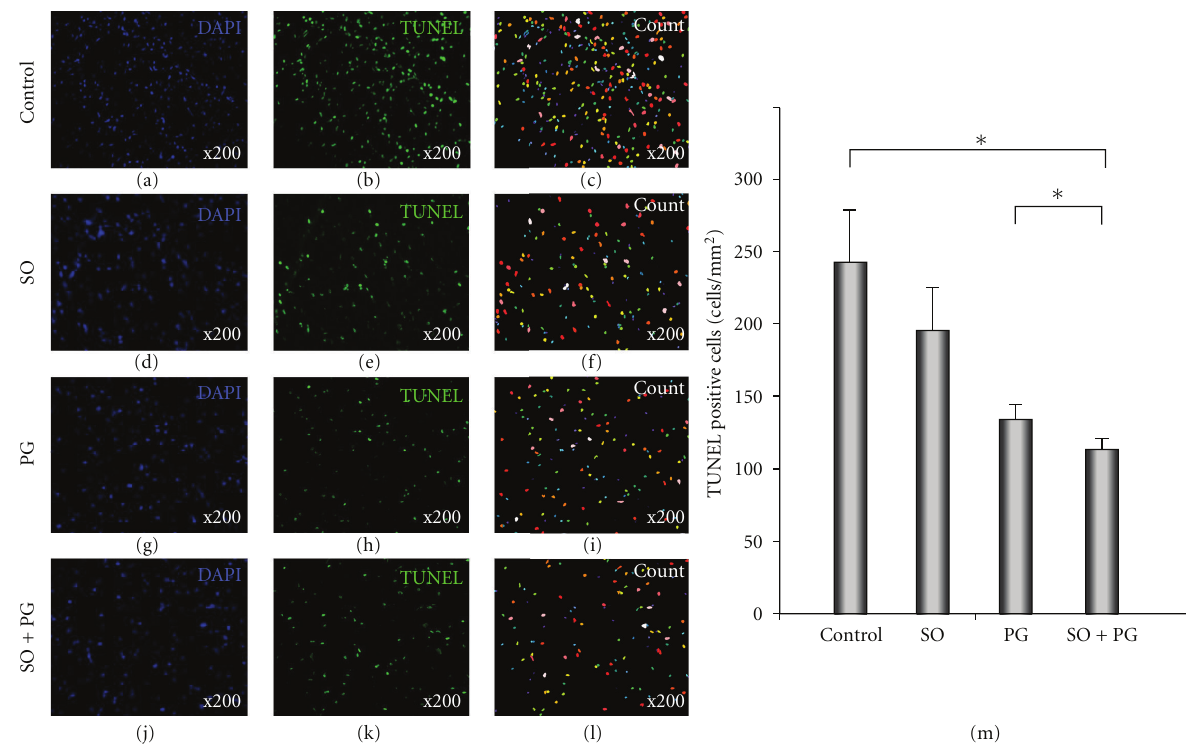
Figure 4: Quantitative analysisof the TUNEL staining for identifying apoptotic cells. Apoptotic cells were identified by immunofluorescence FITC (green; (b), (e), (h), (k)) and DAPI (blue; (a), (d), (g), (j)). TUNEL positive cells were counted using Meta-Morph program (c), (f), (i), (l). (m) shows the quantitative data for TUNEL positive cells. The SO + PG group was significantly decreased compared to Con and PG. ∗ P < . 05.